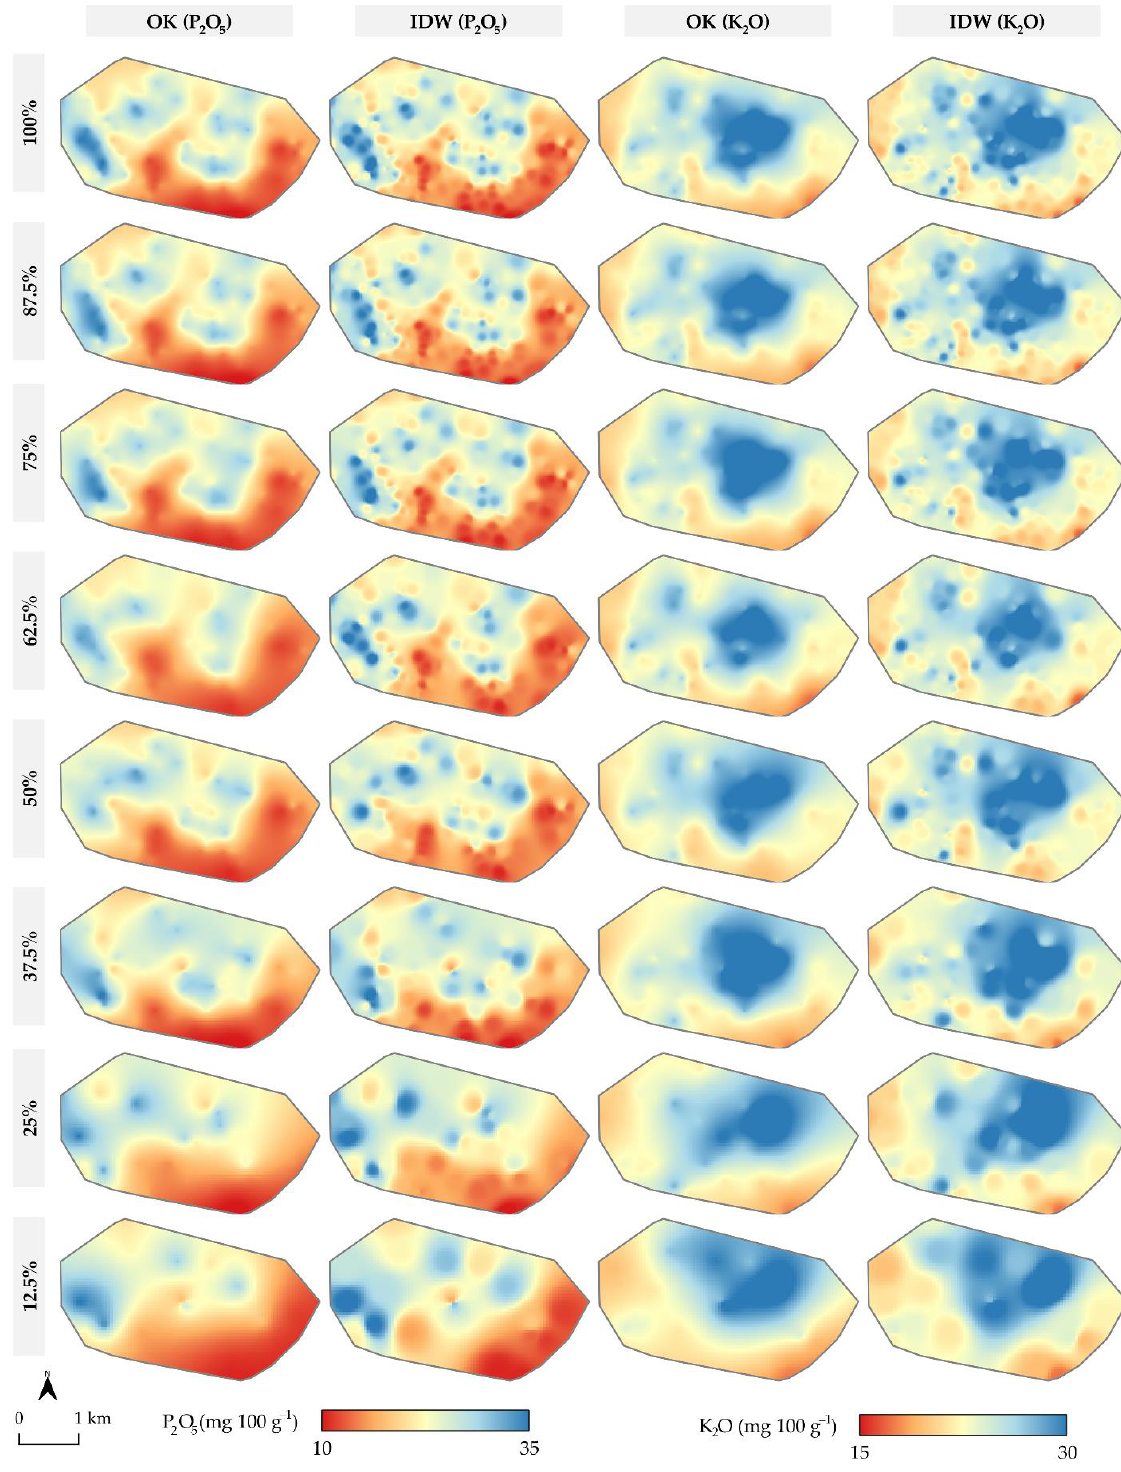
Figure 5. Interpolation results for the combination of eight soil subsets with P 2 O 5 and K 2 O values. Both R 2 and RMSE representing the interpolation accuracy of the combined OK and IDW results indicated a strong correlation to the sampling density (Figure 6). Sampling density resulted as a prime indicator of the interpolation accuracy, having a superior correlation with R 2 and RMSE for both soil chemical properties. The spatial autocorrelation represented by Moran ’ s I showed a lower impact on the interpolation accuracy, with a slightly higher impact on lower spatial autocorrelation P 2 O 5 values.